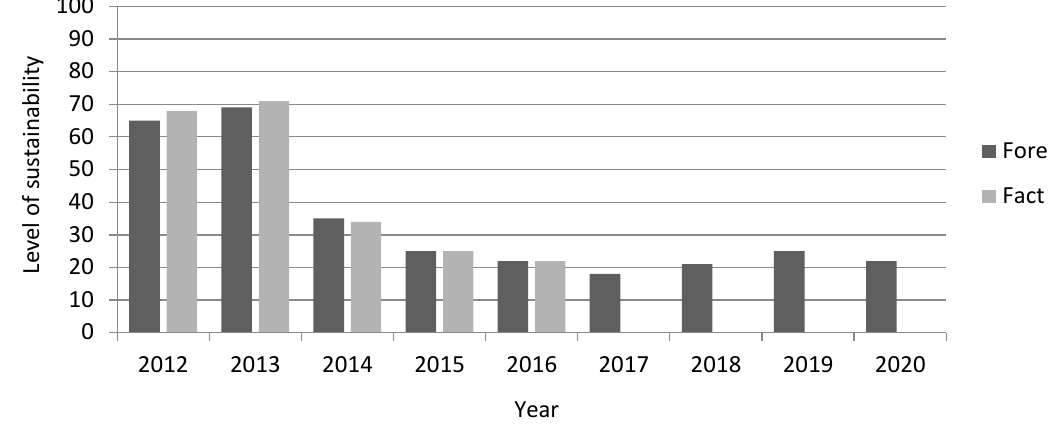
Figure 2. Forecasting the sustainability of Ukrainian